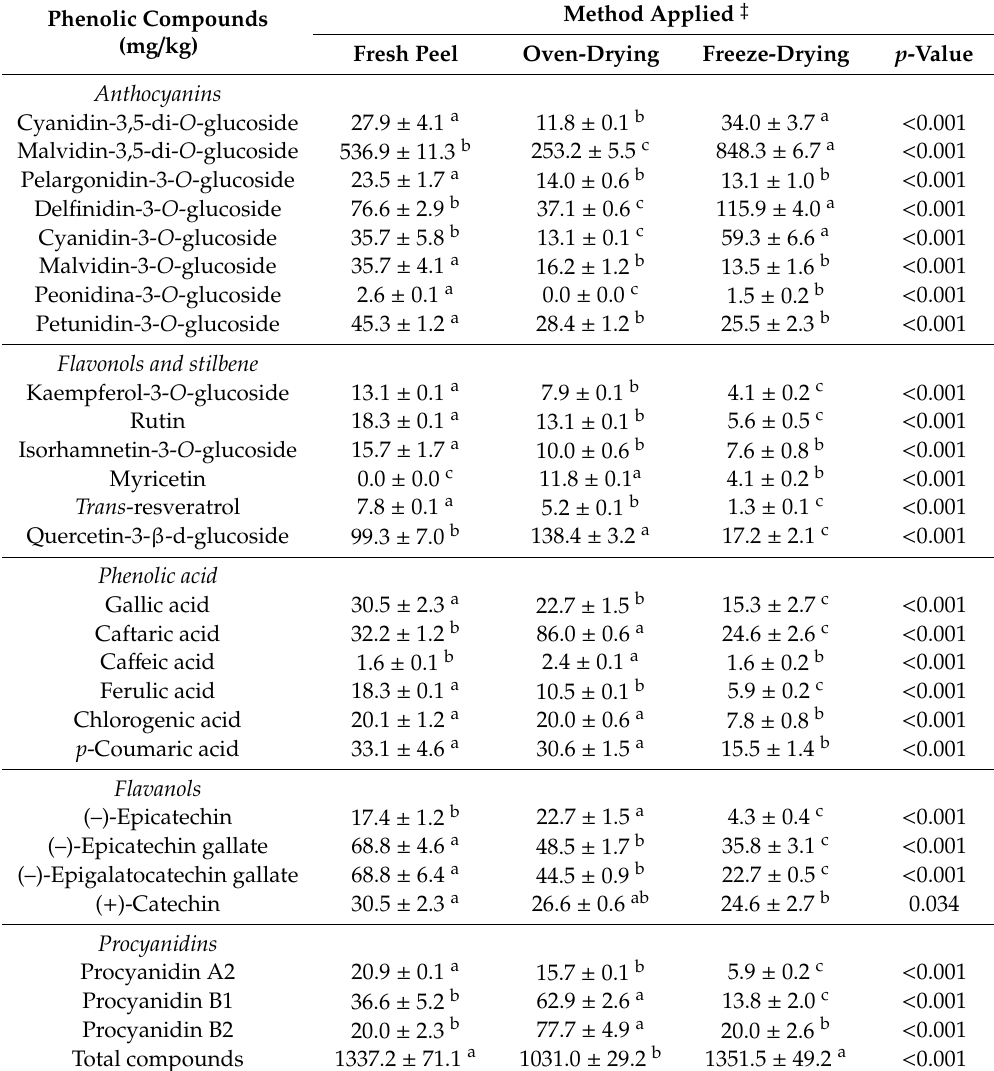
‡ The values of mean ± standard deviation (SD) correspond to averages from three replicates. Di ff erent letters on the same line indicate significant di ff erences between the values ( p <